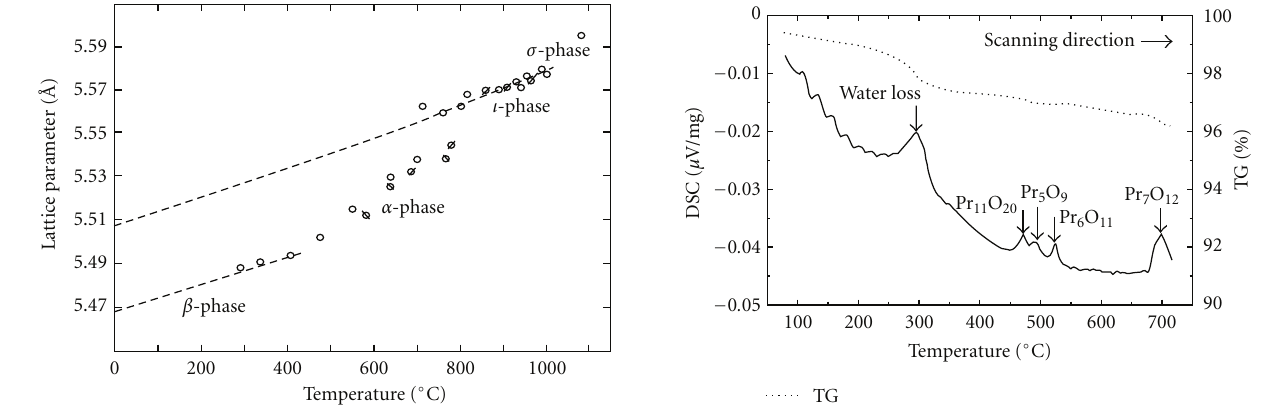
Figure 4: Results of thermal analysis of a sample of Pr 6 O 11